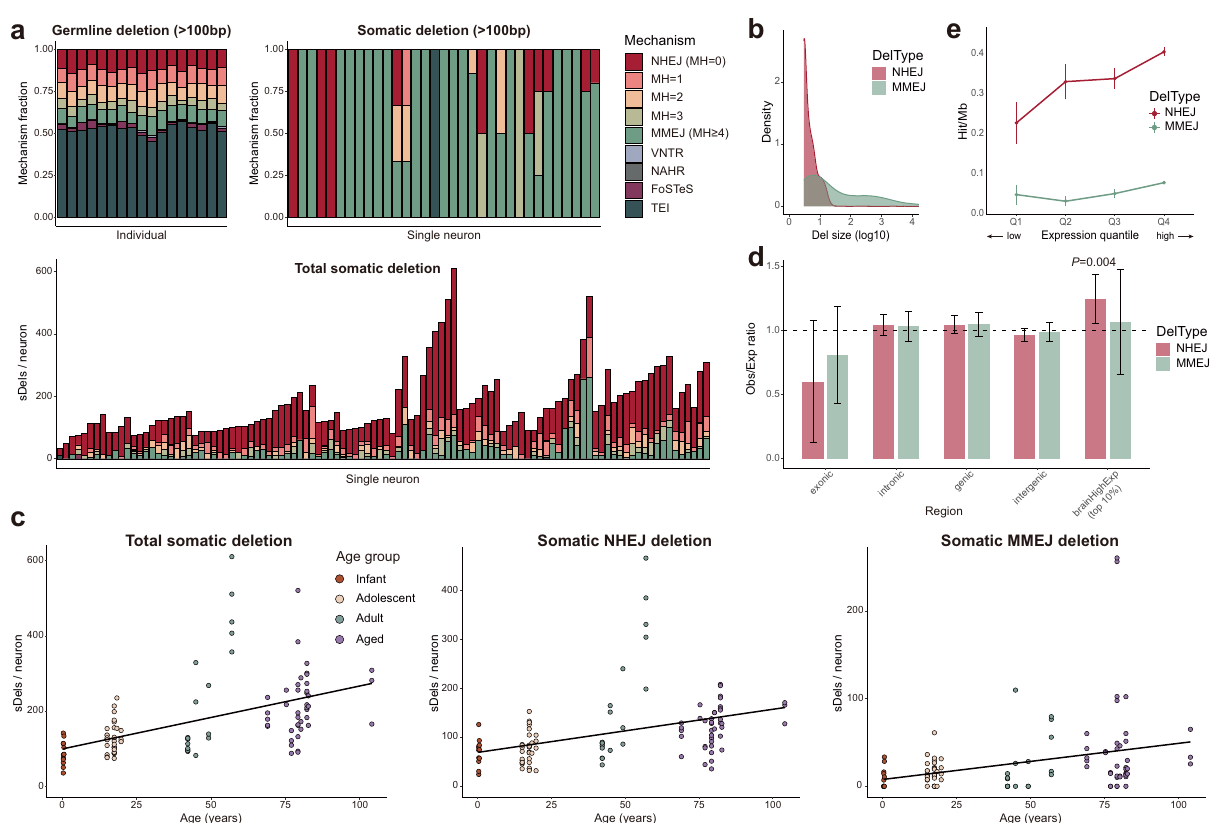
Fig. 3 | Somatic nanodeletions in single-neurons increase with age and re fl ect distinctive underlying repair mechanisms. a Contributions of the predicted mechanisms to deletion formation: germline deletions (>100bp) per individual (upper left, 18 individuals), somatic deletions (>100bp) per cell (upper right, 31 cells), and total somatic deletions per cell (lower, 107 cells). Individuals and single neurons are presented in order of age and deletion rate within each indivi- dual. Single cells with all deletions <100bp are omitted in the upper right panel. Detailed criteria for mechanism prediction are described in Methods. MH micro- homology. b The size of NHEJ- and MMEJ-based somatic deletions. c Somatic